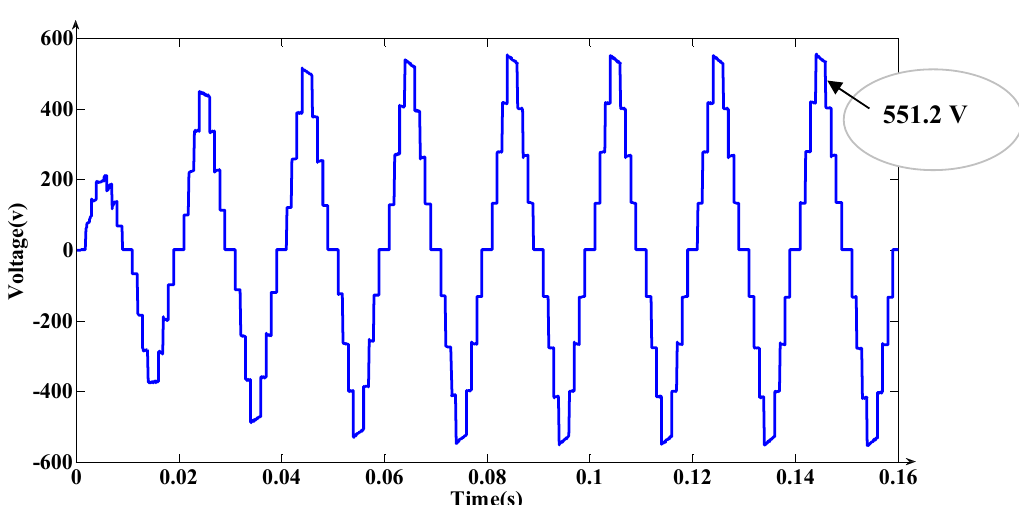
Figure 38. Ripple waveform for output voltage of PI-based BDC.